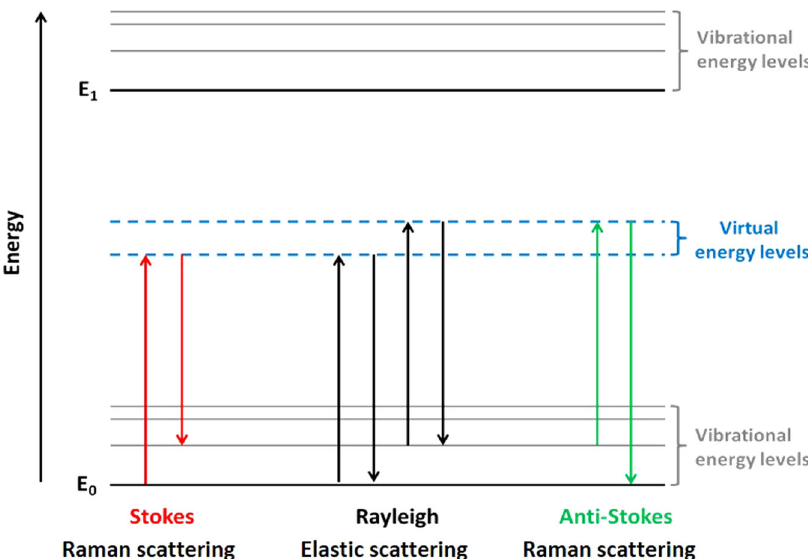
Fig. 1 "Jablonski" style diagram of energetic transitions involved in Raman scattering. Rayleigh scattering is elastic; the incident photon is of the same energy as the scattered photon. Raman scattering is inelastic; in Stokes scattering, the incident photon is of greater energy than the scattered photon, while in anti-Stokes scattering, the incident photon is of lower energy